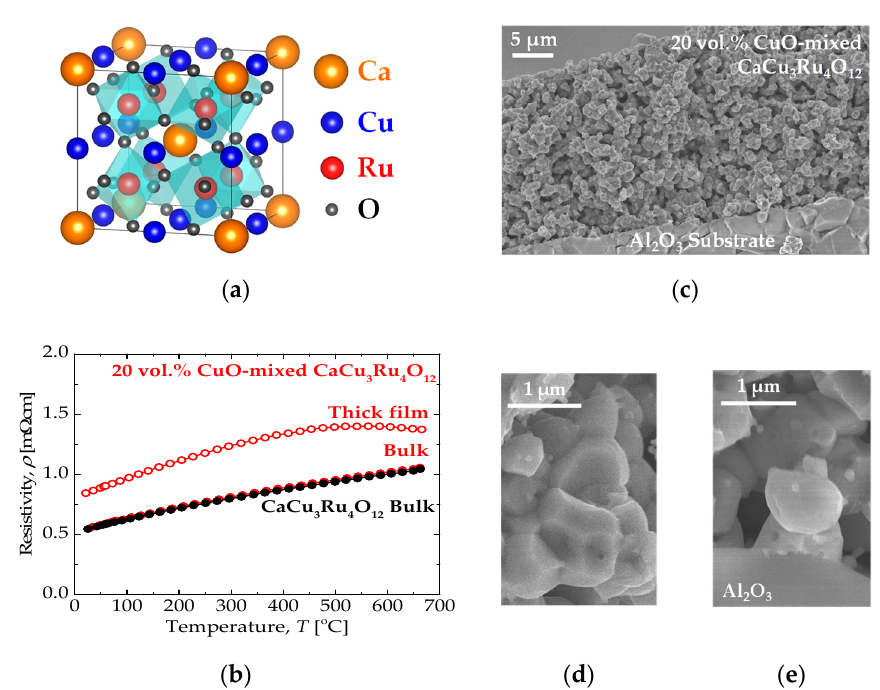
Figure 1. ( a ) Crystal structure of CaCu 3 Ru 4 O 12 . ( b ) Temperature dependence of the resistivity of a CaCu 3 Ru 4 O 12 bulk, a 20 vol. % CuO-mixed CaCu 3 Ru 4 O 12 bulk, and a 20 vol. % CuO-mixed CaCu 3 Ru 4 O 12 thick film. ( c ) Cross-sectional SEM image of a 20 vol. % CuO-mixed CaCu 3 Ru 4 O 12 thick film on an alumina substrate. ( d ) and ( e ) are magnified images of the film and the film–substrate interface, respectively, shown in ( c ).